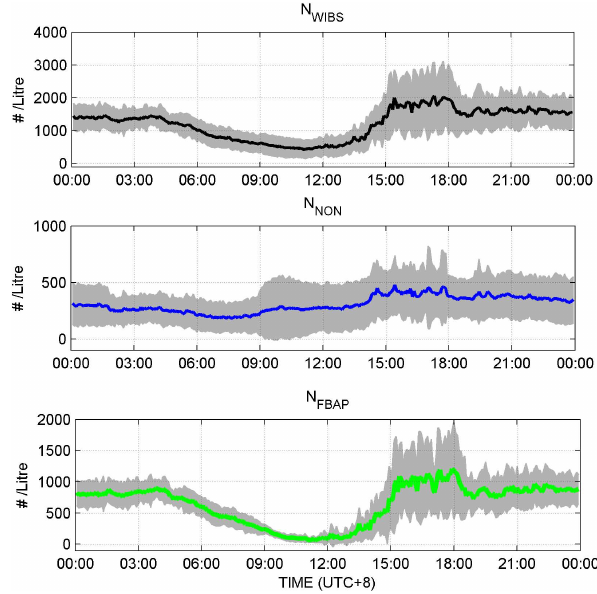
Fig. 5. Diurnal average of N WIBS , N NON and N FBAP at the under- storey site. The shaded area represents ± 1standard deviation.